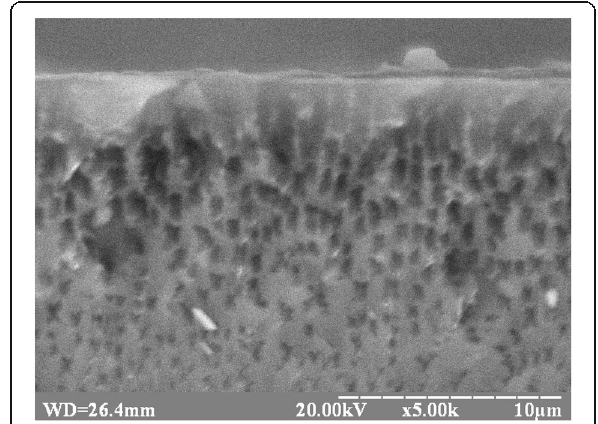
Fig. 1 SEM image of the cross sections of the PS – RGO